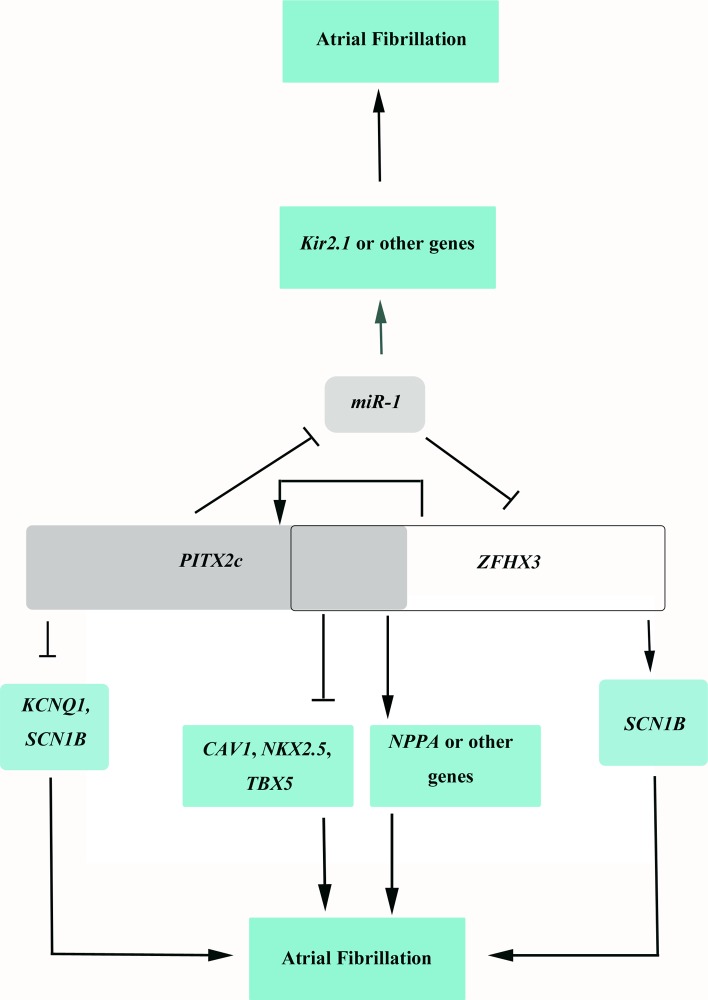
A schematic diagram showing the cyclic cross-regulation of PITX2c and ZFHX3, which underlies the interaction between PITX2c and ZFHX3 involved in the pathogenesis of AF.